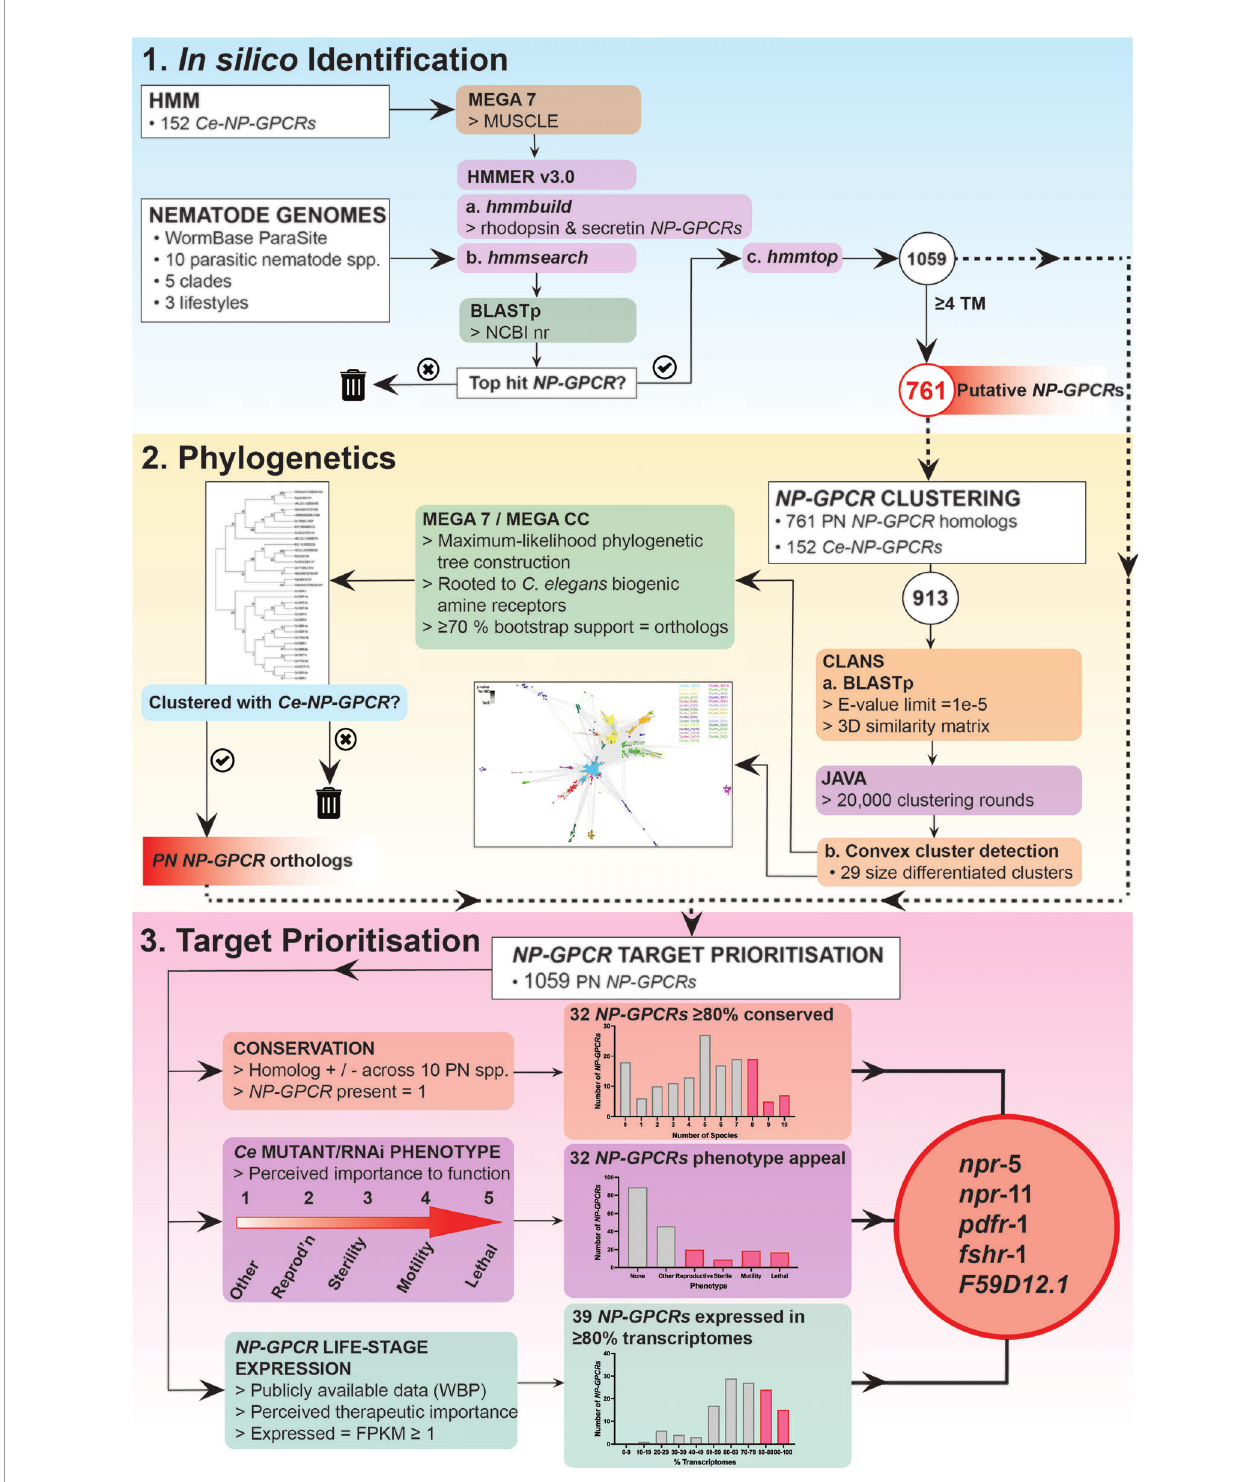
FIGURE 1 | NP-GPCR drug target prioritization pipeline demonstrating NP-GPCR identi fi cation, phylogenetics and target prioritization work fl ow and a summary of the data generated at key stages in the pipeline. Five parasitic nematode NP-GPCRs are prioritised for validation in parasites: npr -5, -11, pdfr -1, fshr -1 and F59D12.1 . HMM, Hidden Markov Models; TM, transmembrane domains; PN, parasitic nematode; CLANS, Cluster Analysis of Sequences; Ce, Caenorhabditis elegans ; Reprod ’ n, reproduction; EXP, expression; WBP, WormBase Parasite; KO, knockout; RNAi, RNA